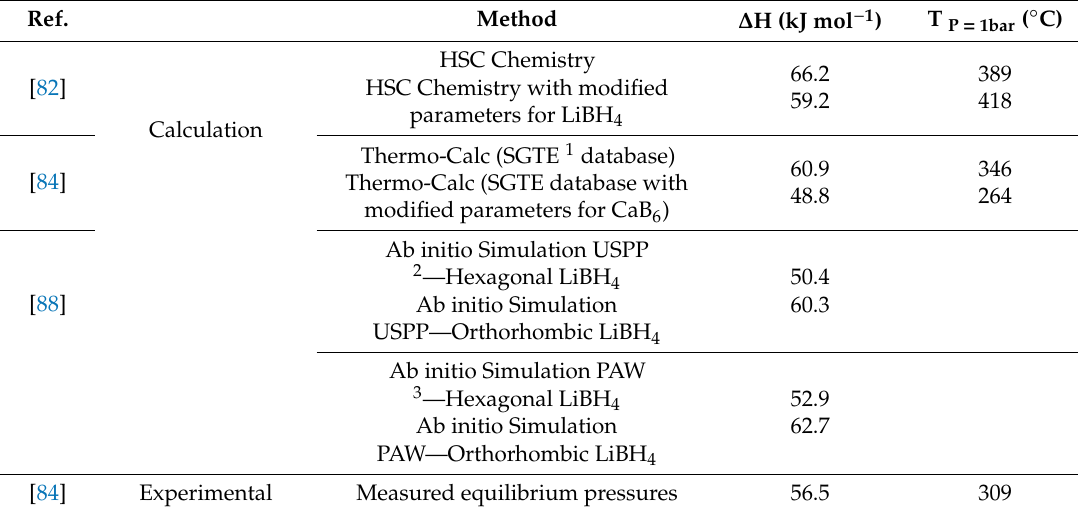
Table 5. Calculated and experimental thermodynamic information. 1 Scientific Group Thermodata Europe, 2 Ultra-Soft Pseudo-Potentials, 3 Projector-Augmented Wave.